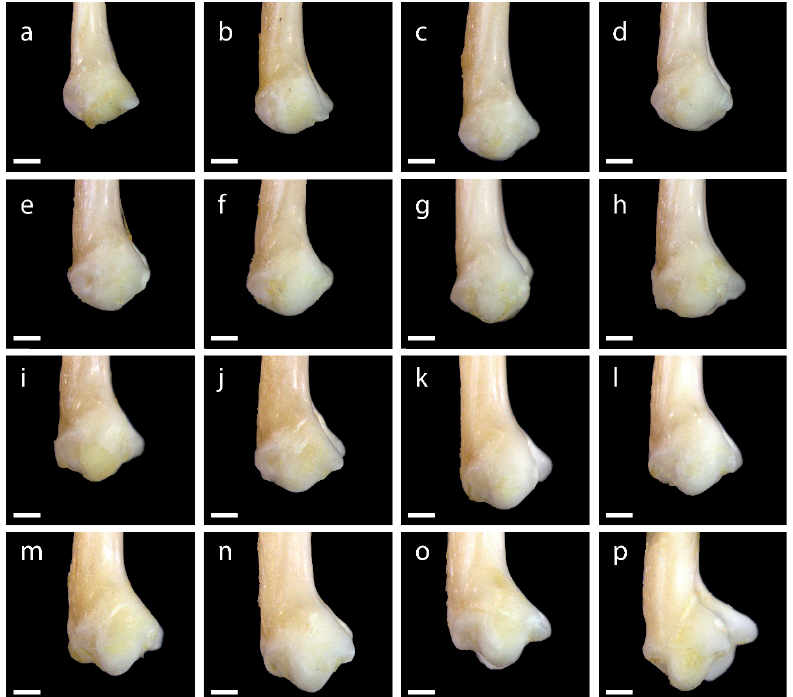
Figure A11. Microscopic images of the lateral left view of the pinnules of P. bichir PO1. The images ( a – p ) correspond to the 1st, 2nd, 3rd, 4th, 5th, 6th, 7th, 8th, 9th, 10th, 11th, 12th, 13th, 14th, 15th, and 16th pinnules, respectively. Scale = 1 mm.